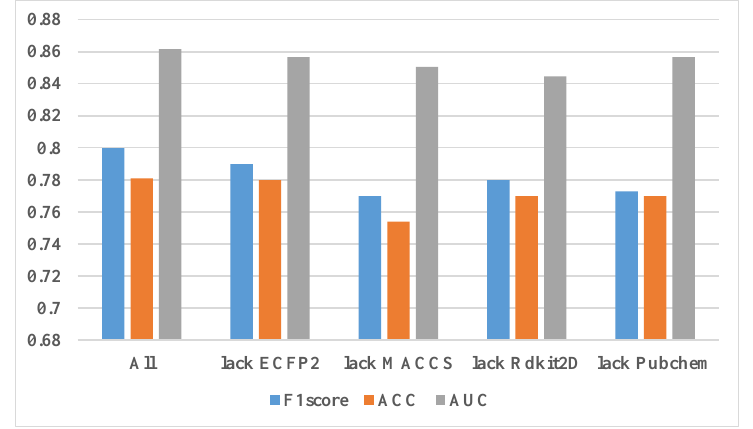
Figure 6. Results of ablation experiments. “ All ” means using all the features, “ lack ECFP2 ” means removing the ECFP2 part of the features from all the features, and so on for other labels.